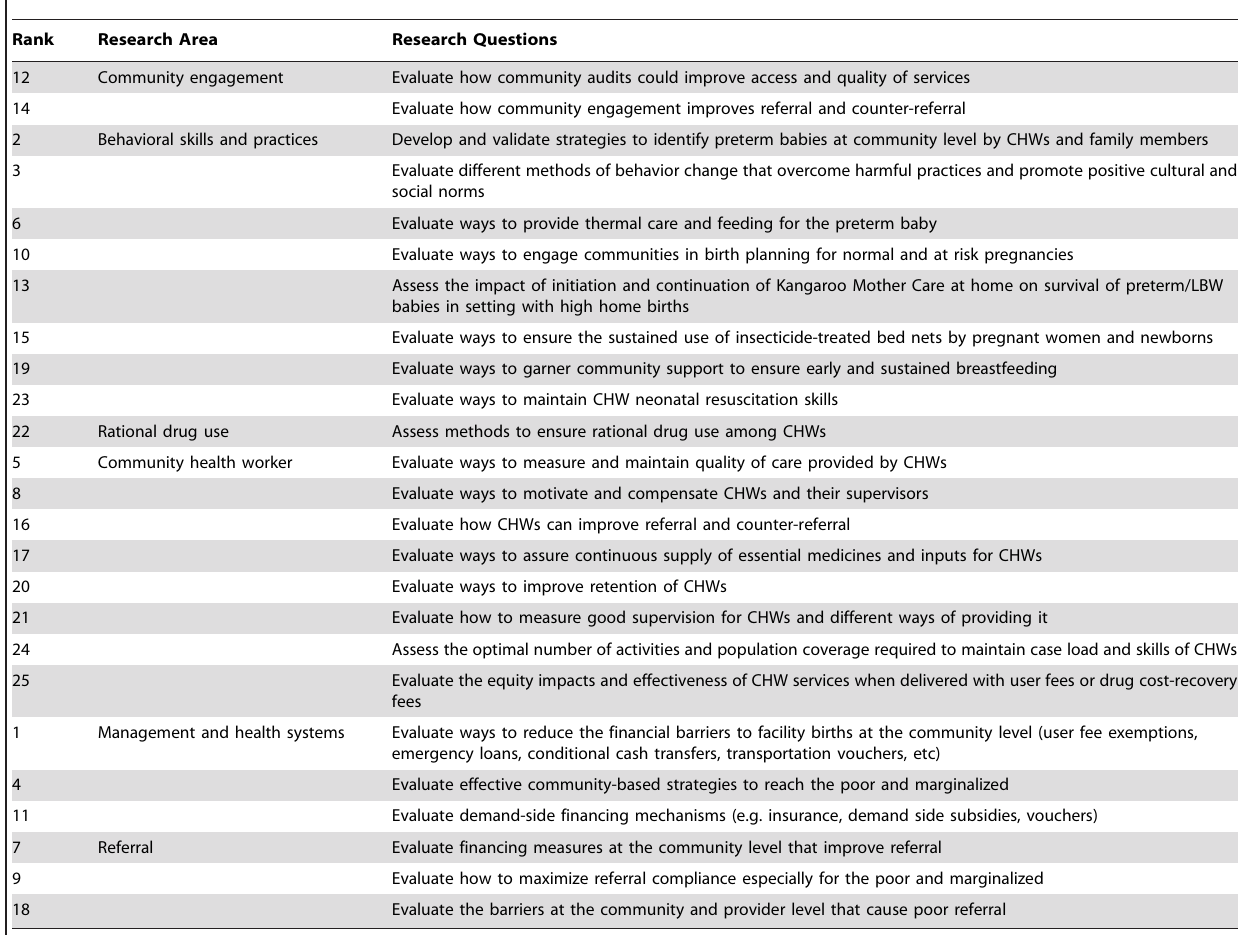
Table 2. Top 25 research questions by research area with a research priority score of 0.7 or